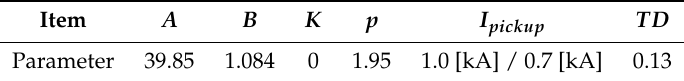
Table 5. The parameters of the overcurrent relay